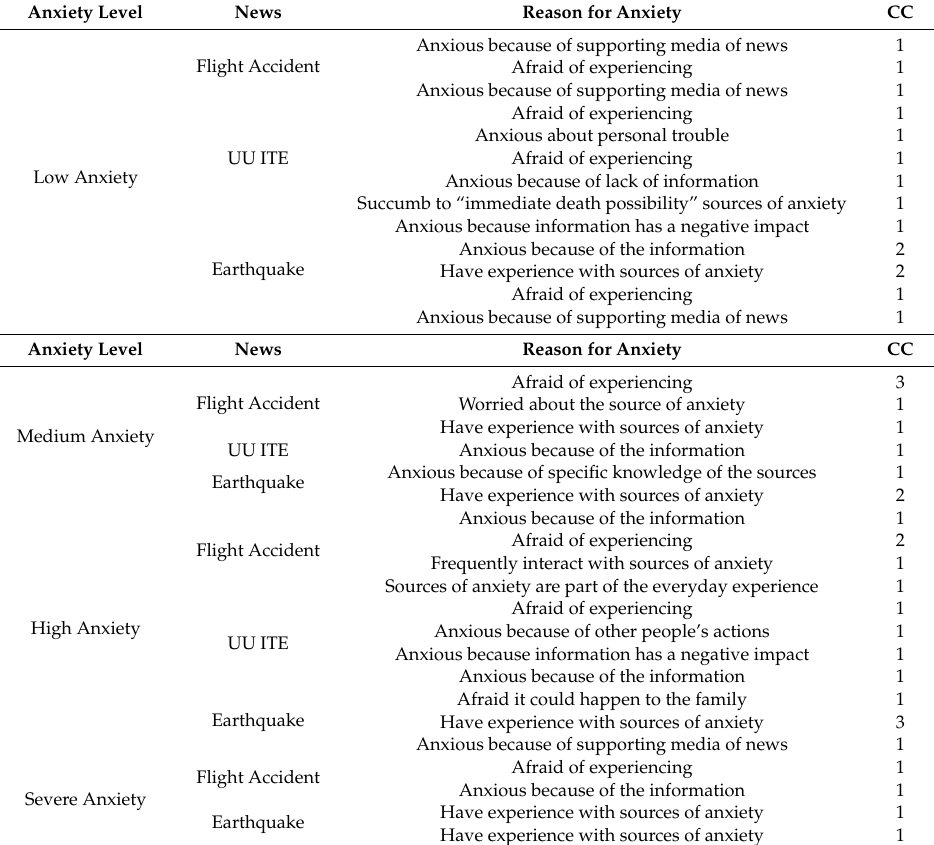
Table 25. Relationship between anxiety level, news, and reason for